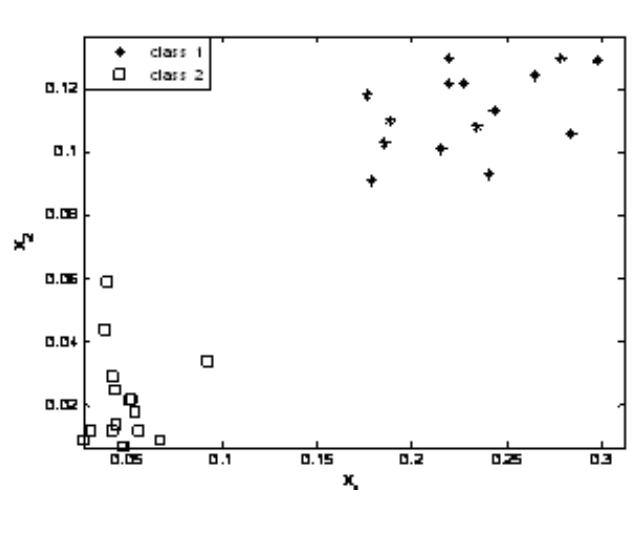
Figure 6. SVM Test